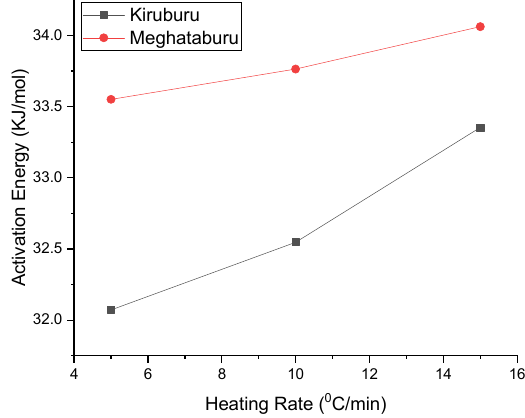
Figure 20. Effect of the heating rate on activation energy.